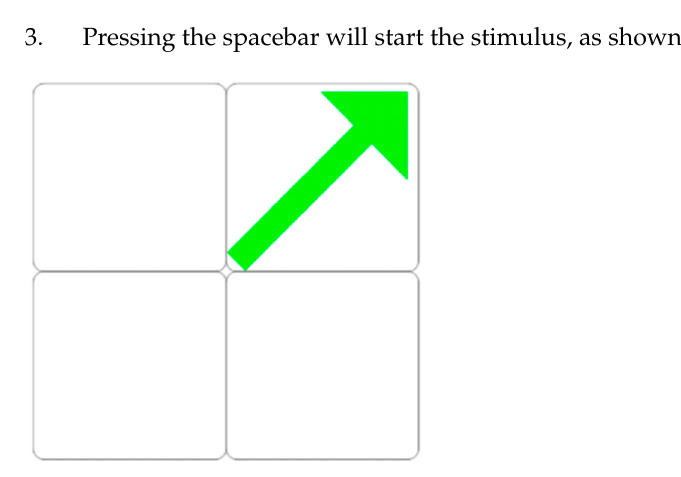
Figure 7. Congruent or incongruent stimulus.